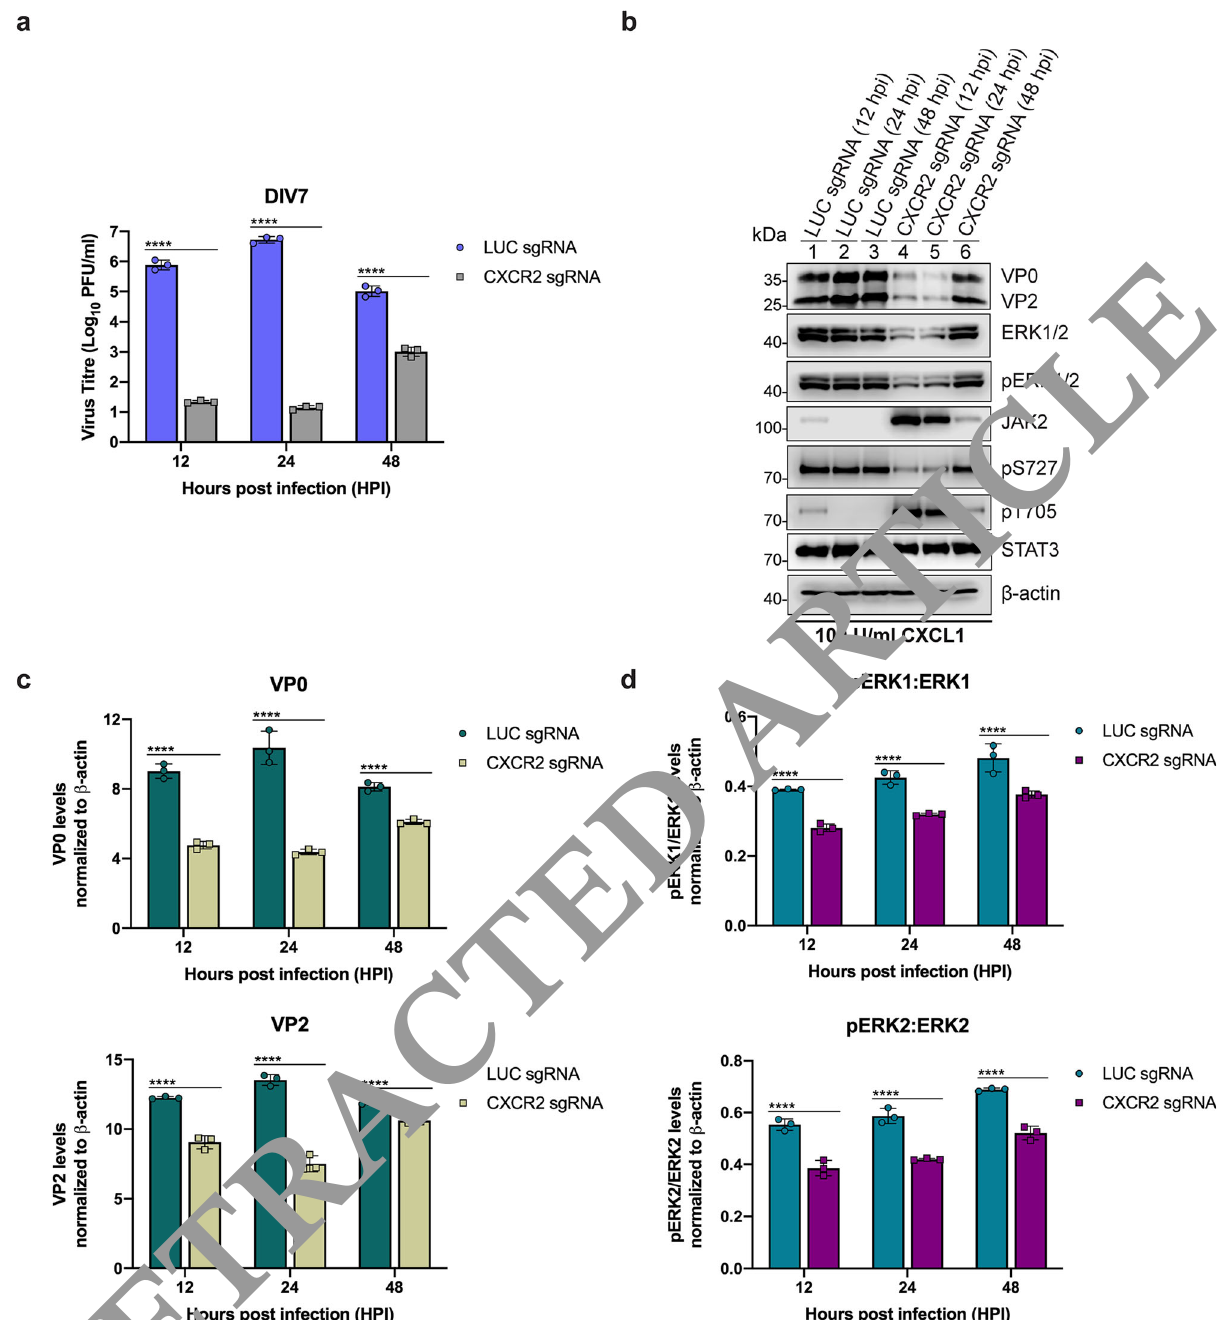
Fig. 6 Blocking CXCL1 signaling by CXCR2 deletion decreases viral replication in neuronal cultures. a CXCR2 deletion in infected neuronal cultures reduced viral titers at all time points tested. b Lysates from neuronal cultures infected with control ( LUC sgRNA)- or CXCR2 sgRNA-expressing lentiviruses were similarly immunoblotted as in a . CXCR2 deletion delays viral protein expression in neuronal cultures despite CXCL1 pretreatment. Immunoblot representative of 3 biological repeats is shown. Bar charts below show the quanti fi cations for each protein. c VP0 and VP2 levels decreased at all timepoints in CXCR2 -deleted samples. d pERK1/2 to ERK1/2 ratios were decreased in CXCR2 -deleted samples. β -actin was used as a loading control for immunoblotting experiments. MOI of 1 was used for all experiments. Data are expressed as the average with error bars representing ±SD from 3 independent experiments ( n = 3). Statistical analyses were performed with two-way ANOVA corrected using Bonferroni post-test. (**** P < 0.0001). Source data are provided as a Source Data fi Collectively, these results uncover the involvement of CXCL1 in causing neurological complications and highlight the feasibility of pharmacologically interfering its signaling in the treatment of severe HFMD infections.